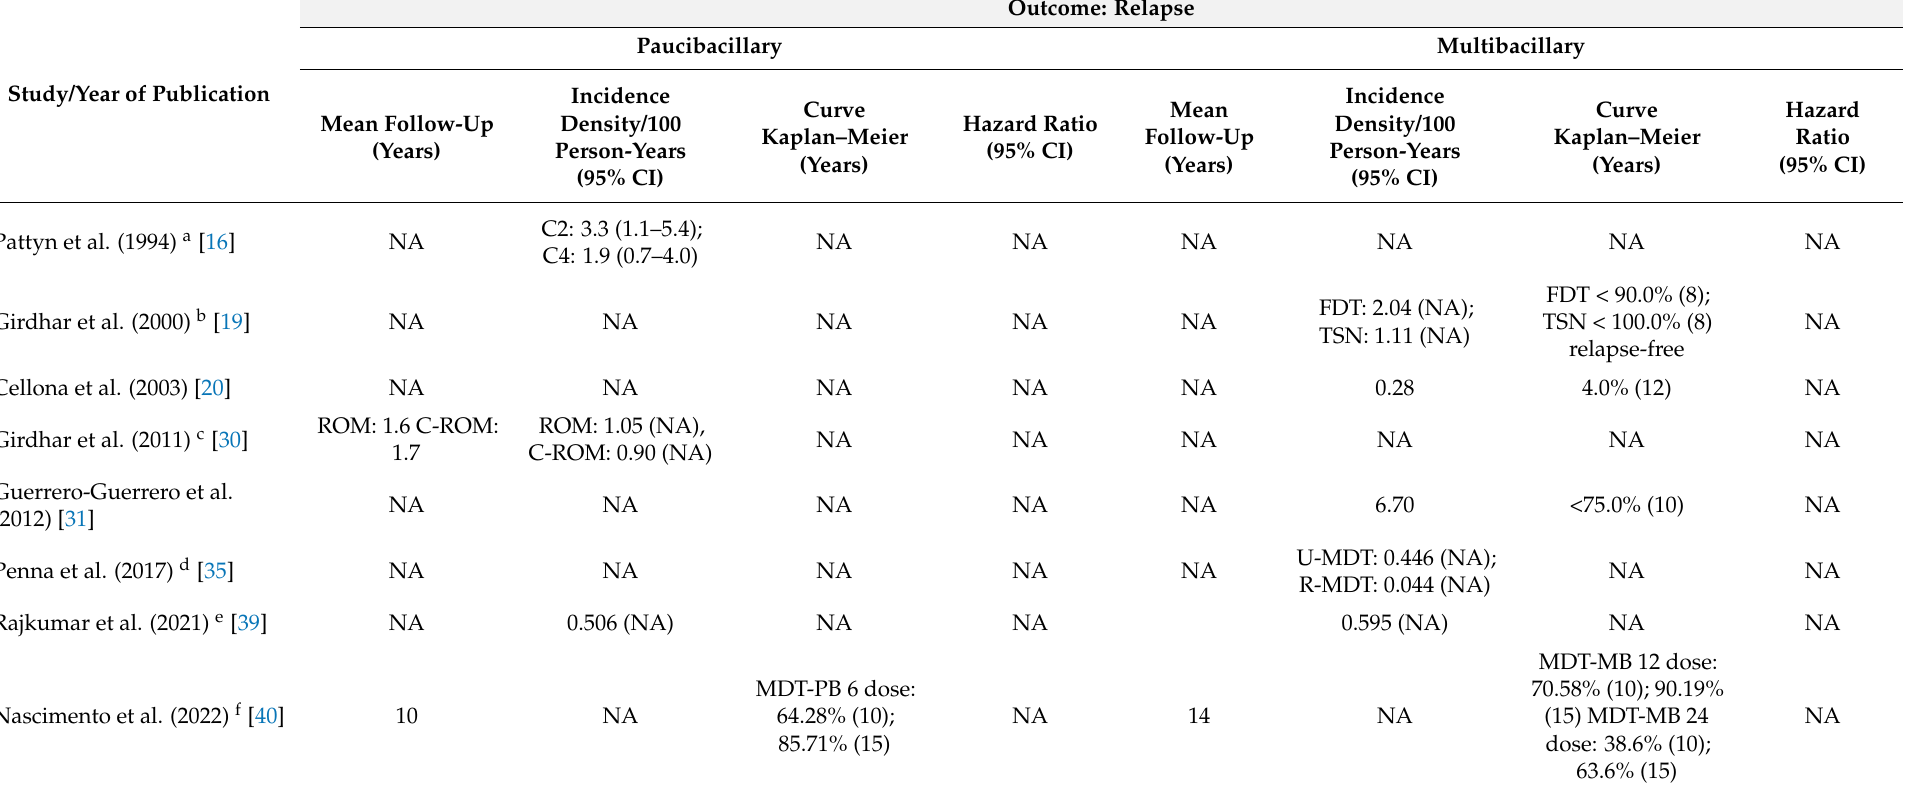
Table 3. Reporting survival analyses of the included studies by outcome